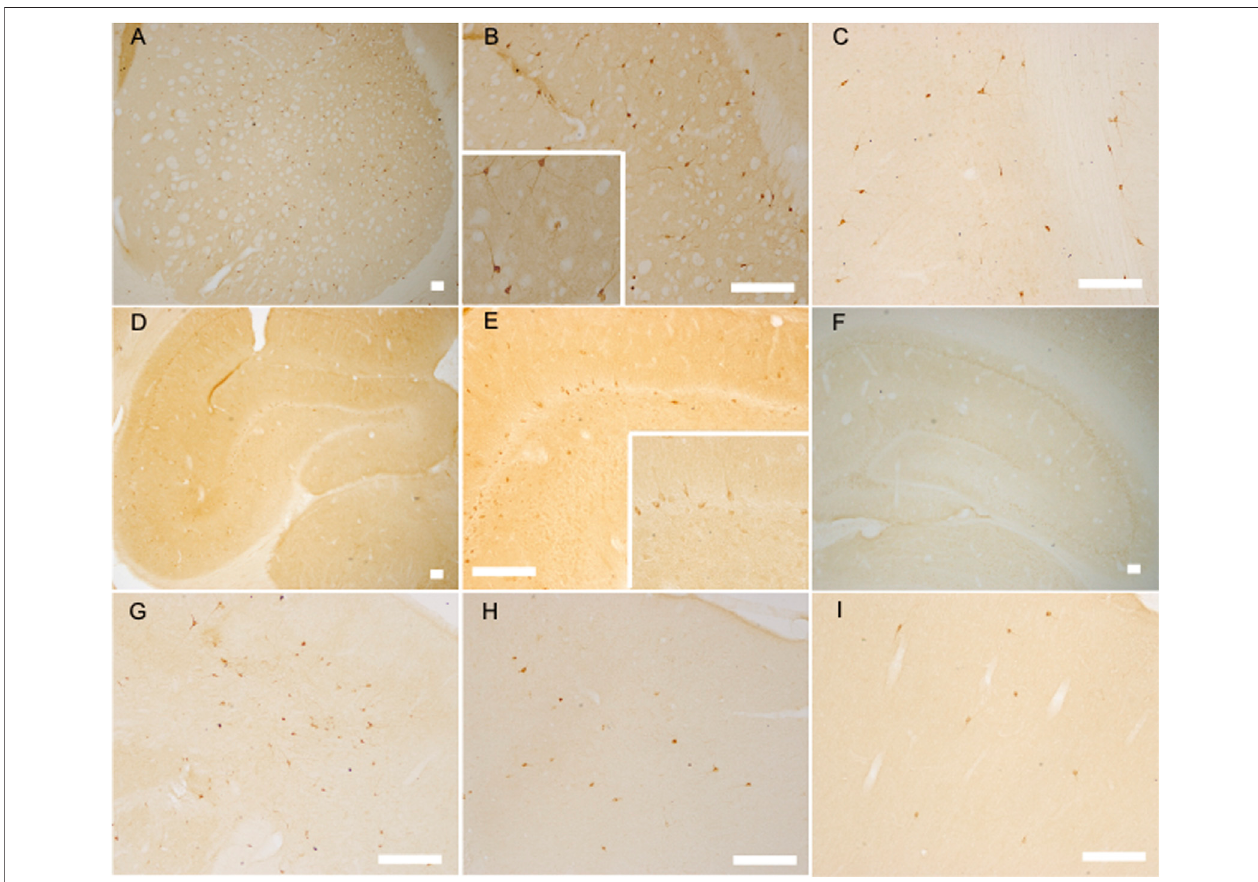
FIGURE3| ThenNOSpositivelabeledneuronsincreasedattheestablishedhypertensionstage(12 weeks)butdecreasedatthesenescencestage(12months)of SHR as analyzed by nNOS immunoreaction. nNOS positive labeled neurons in the striatum of 12 week-old SHR (A,B) (with an ampli fi catory image inserted into B) andWKY (C) ,thehippocampusof12 week-oldSHR (D,E) (withanampli fi catoryimageinsertedintoE)andWKY (F) ,thefrontalcortexof12-week-oldSHR (G) andWKY (H) , the frontal cortex of 12 month-old SHR (I) , bar = 100 μ m.